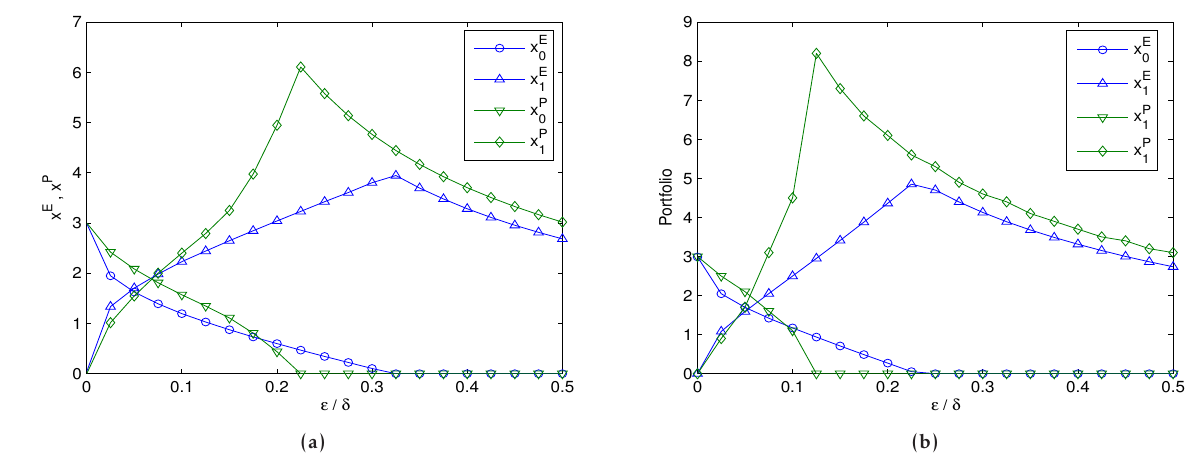
Figure 2. Number of primary ( x E DSR and DSP constraint. a) Demand and the secondary bandwidth return are independent, b) Demand and the bandwidth return are correlated.